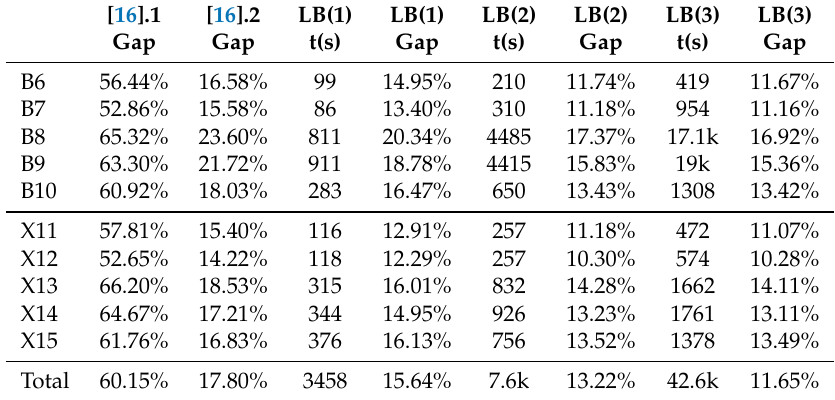
Table 7. Comparing with [16] the dual bounds using LP+cuts computations of LB ( k 0 ) with k 0 < 3.